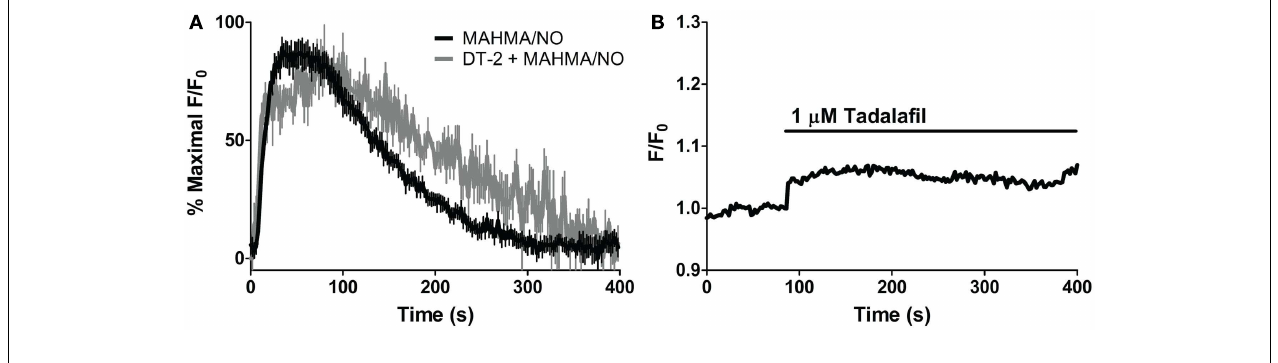
peak (1 µ M, gray) each normalized to percent maximal F/F0 ratio. (B) Application of the PDE5-specific inhibitor, tadalafil (1 µ M). Shown is the average mean value, n = 8.